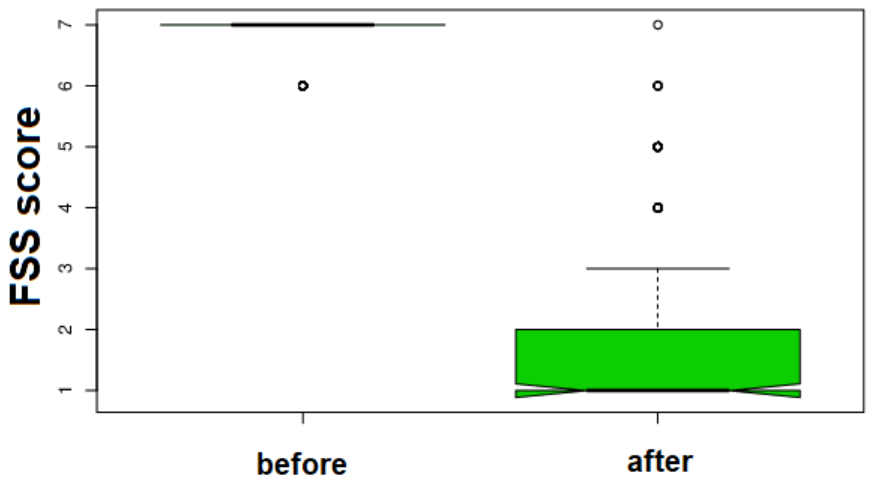
Figure 1. Box plot representation of the impressive change in fatigue symptoms at 30 days after oxygen-ozone autohemotherapy in the 200 patients treated with O 2 -O 3 -AHT.